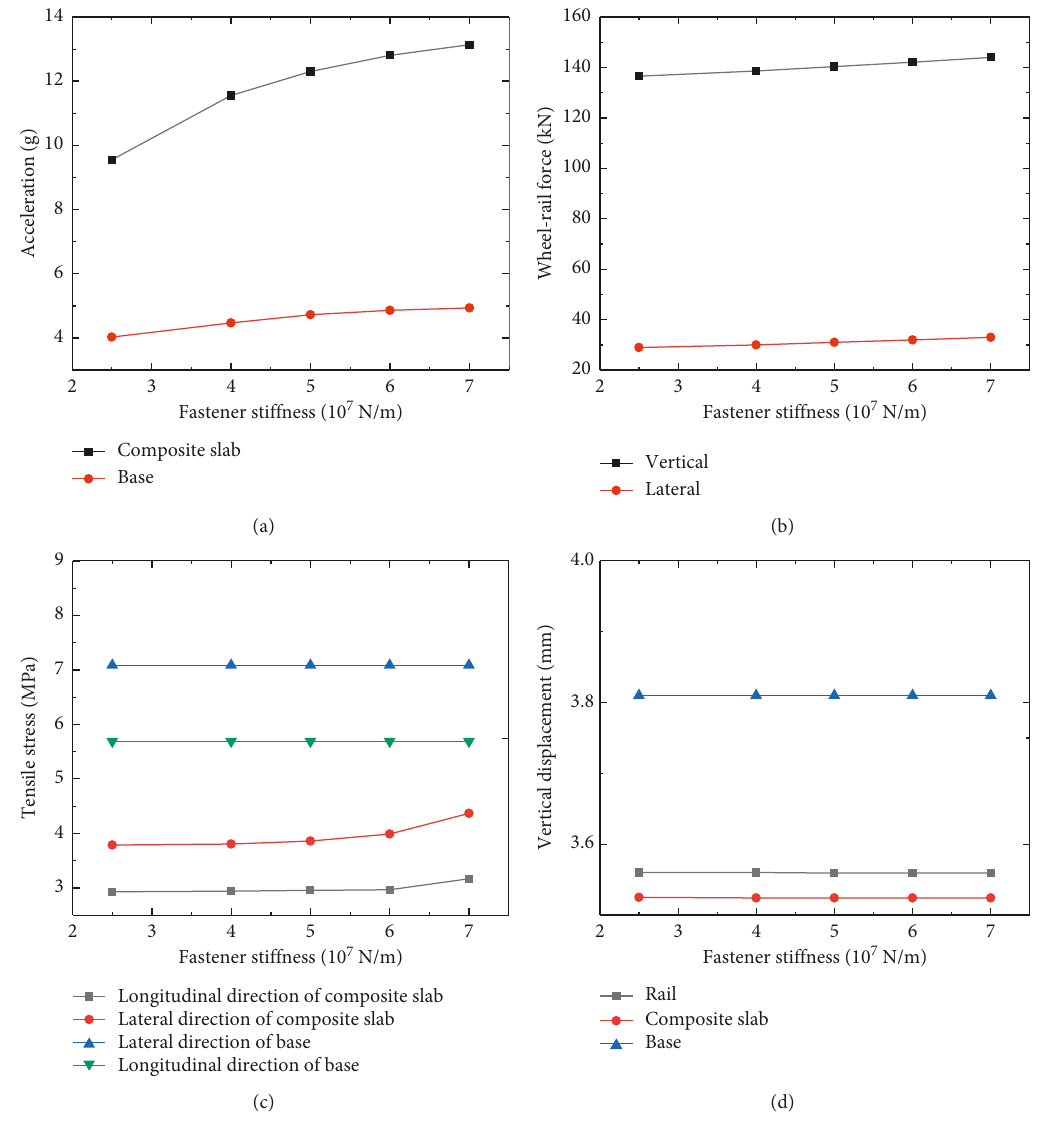
Figure 3: The maxima of the dynamic responses of the vehicle-track system with different fastener stiffnesses. (a) The vertical accelerations of composite slab and base. (b) The wheel-rail force. (c) The tensile stress of composite slab and base. (d) The vertical displacement of rail, composite slab, and